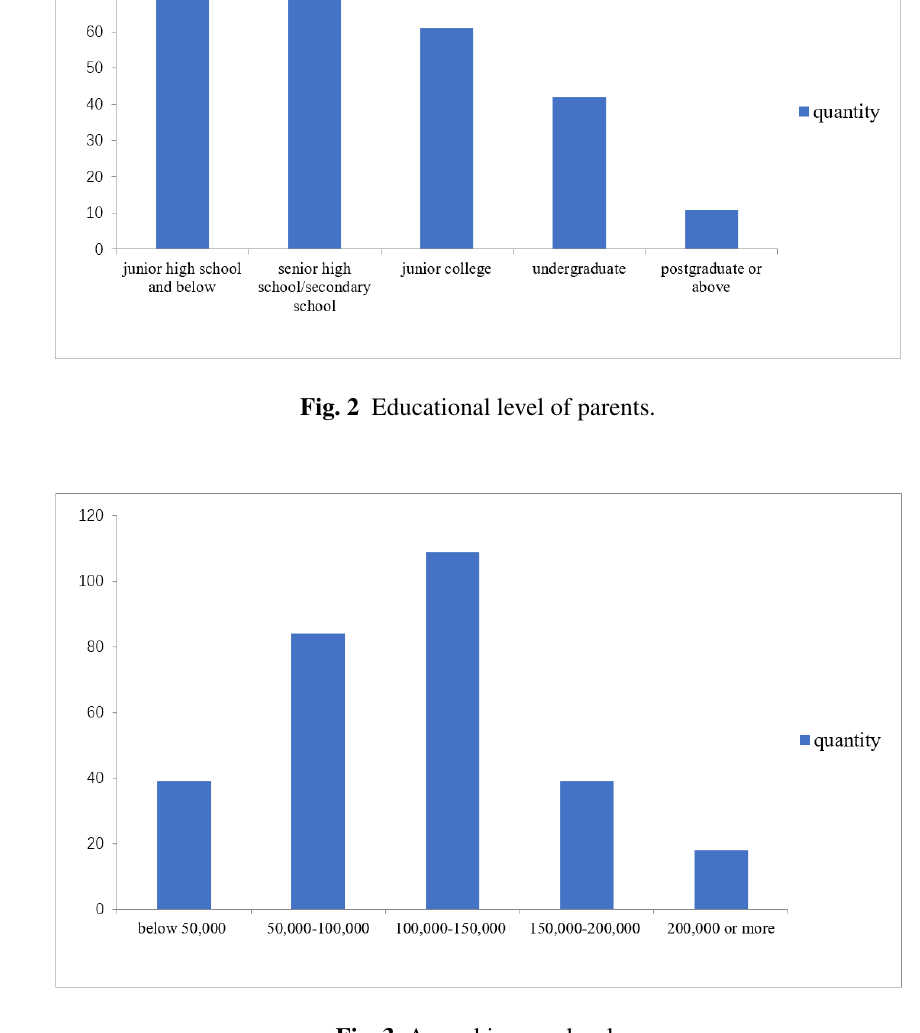
Fig. 3 Annual income